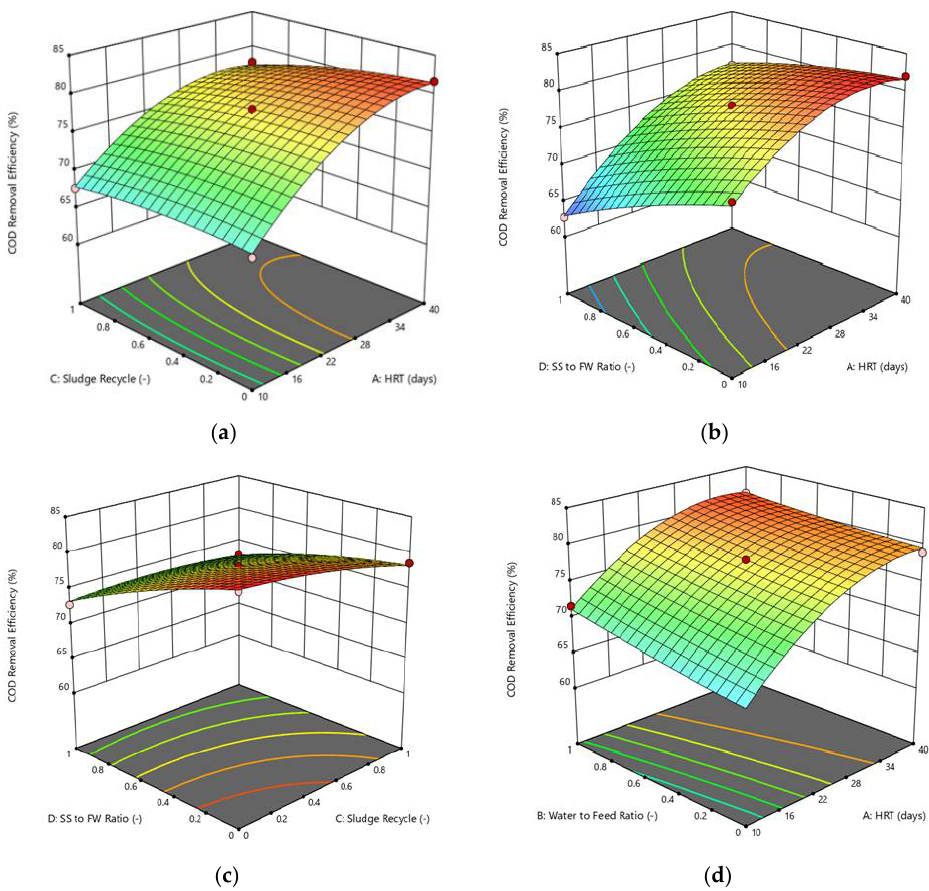
Figure 5. 3D surface graph plot for COD removal efficiency as a function of ( a ) HRT and sludge recycle ratio; ( b ) HRT and SS to FW Ratio; ( c ) sludge recycle ratio and SS to FW ratio; ( d ) HRT and water to feed ratio.